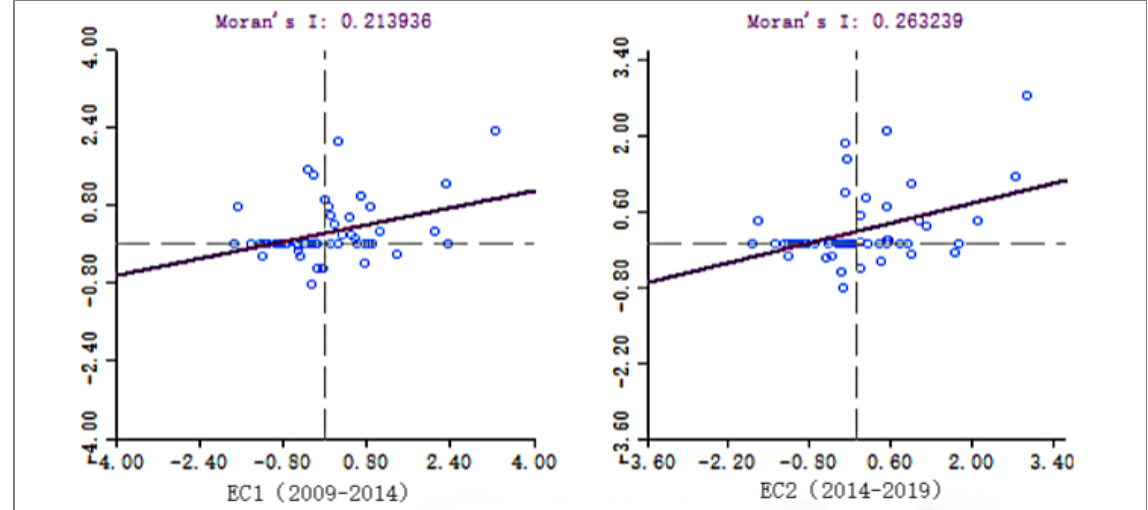
Figure 11. Scatter plot of the global Moran index of the 2−period elasticity coefficient.